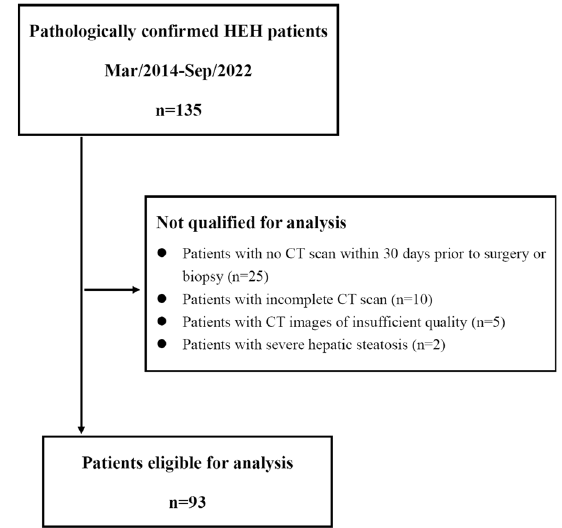
Fig. 1 Patient flow chart for inclusion. A total of 135 pathologically confirmed hepatic epithelioid hemangioendothelioma (HEH) patients were regularly followed up in our center. Excluded were 25 patients with no CT scan within 30 days prior to surgery or biopsy, 10 patients with incomplete CT scan, 5 patients with CT images of insufficient quality and 2 patients with severe hepatic